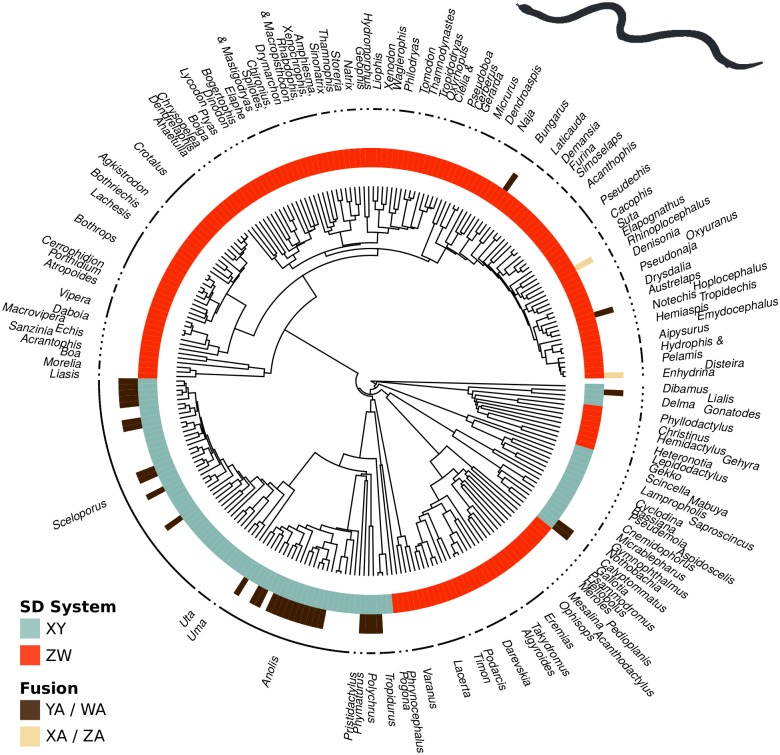
Sex chromosome fusions (outer circle) and sex determination system (inner circle) mapped onto the phylogenetic tree of squamate reptiles.The vast majority of fusions occur in XY systems (aqua) and involve Y-A fusions (brown).